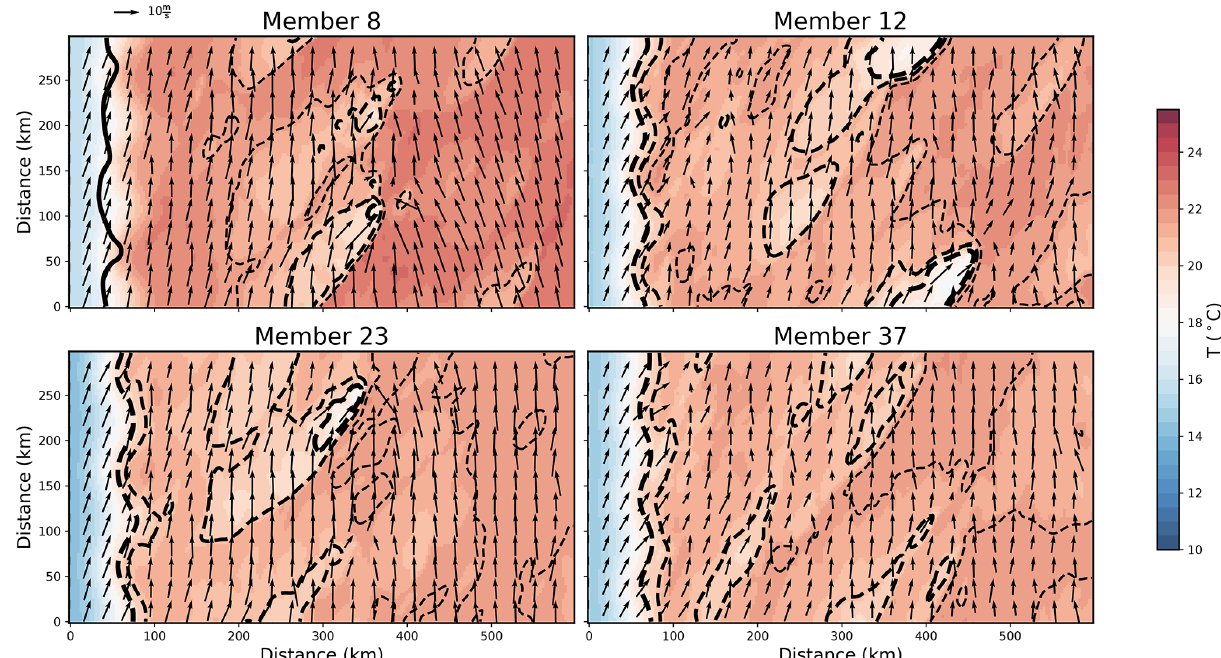
Figure 6. Forecast air temperature at the lowest model level (25ma.g.l.) at the time of ensemble initialization (00:00UTC). Forecast wind speeds sampled at 500ma.g.l. are plotted with arrows. The differences between the forecast and nature run temperature are contoured in 1 ◦ C increments. Contours that are dashed (solid) indicate where the forecast is cooler (warmer) than the nature run. Contours become thicker as the error